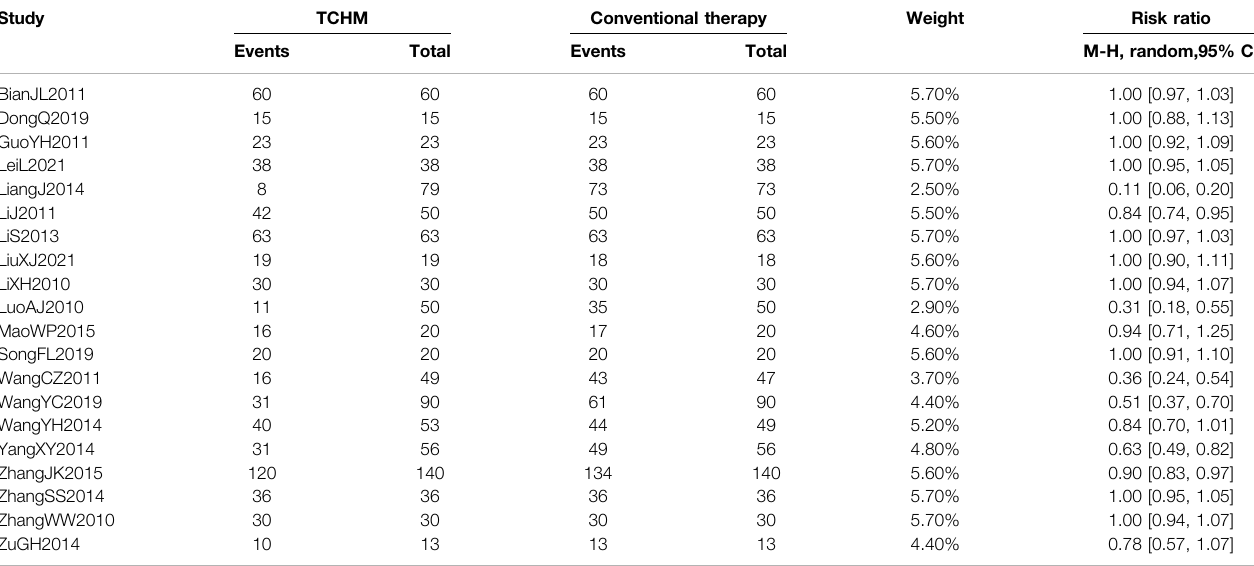
TABLE 2 | Effect of value for incidence rate of radiodermatitis with TCHM.